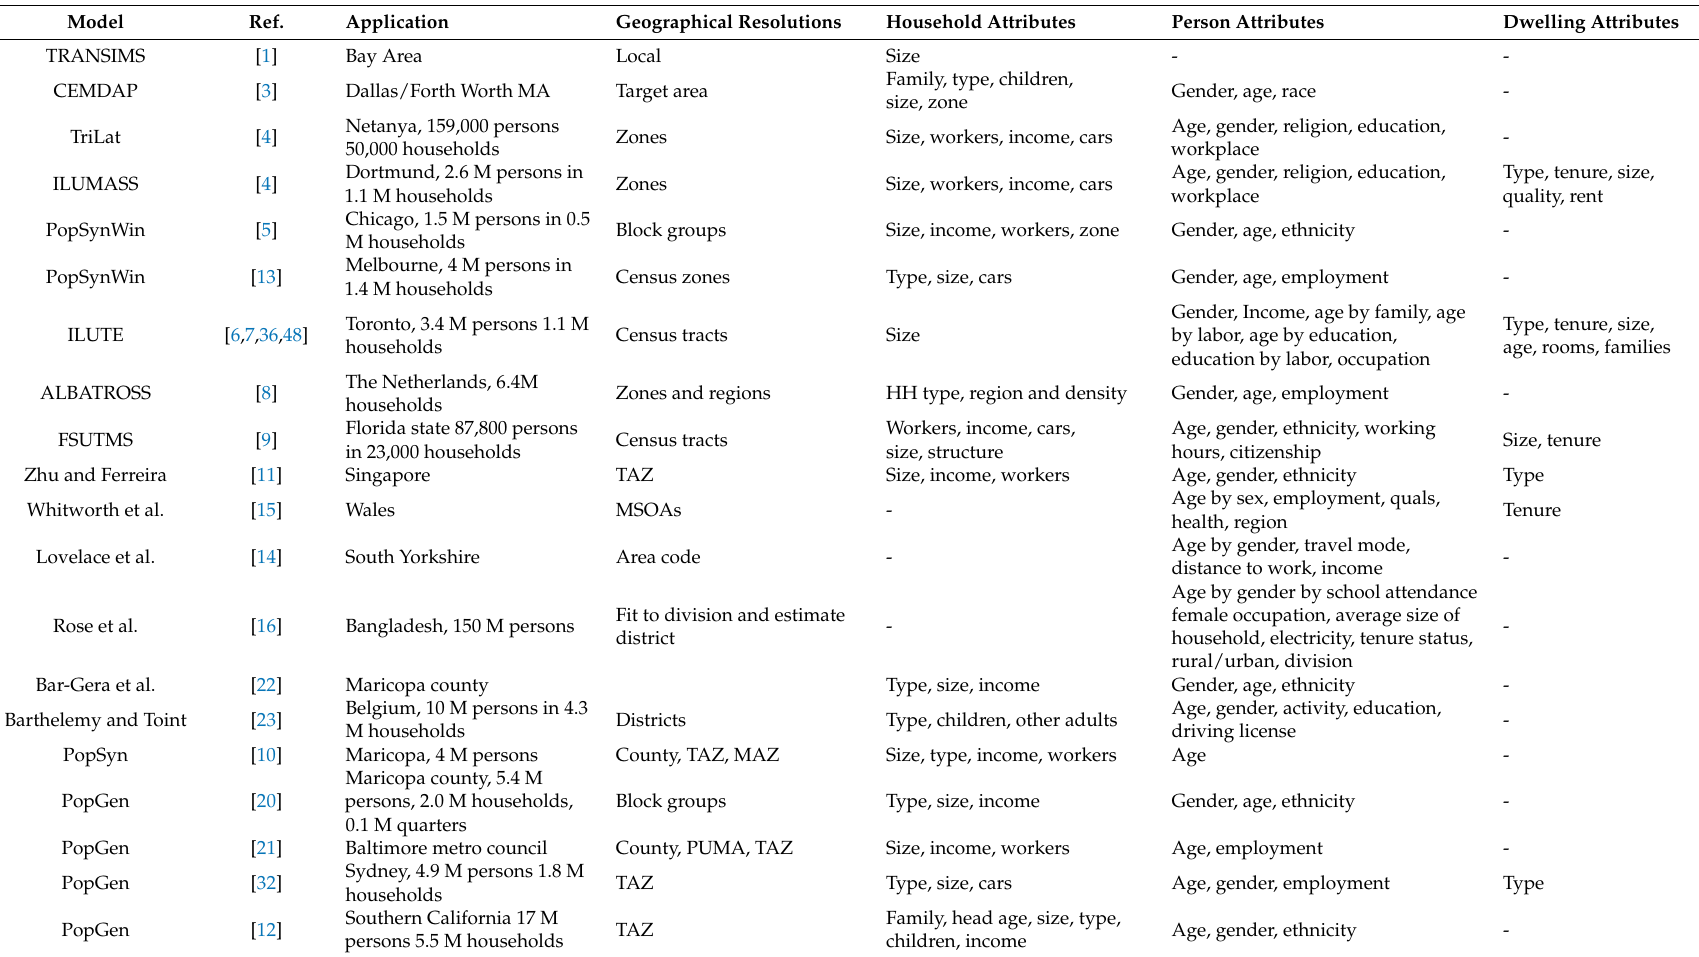
Table A2. Summary of previous population synthesis based on geographical area, location, and